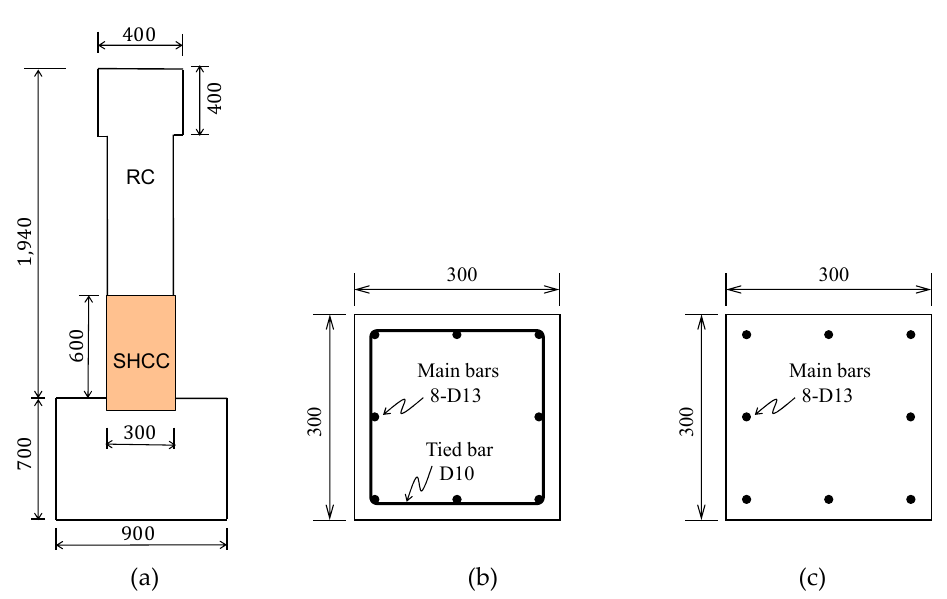
Figure 3. Layout of column specimen with cross-section (unit: mm): ( a ) dimensions; ( b ) cross-section (tied bars); ( c ) cross-section (no Tied bars). Three column specimens were presented with design variables as shown in Table 1.